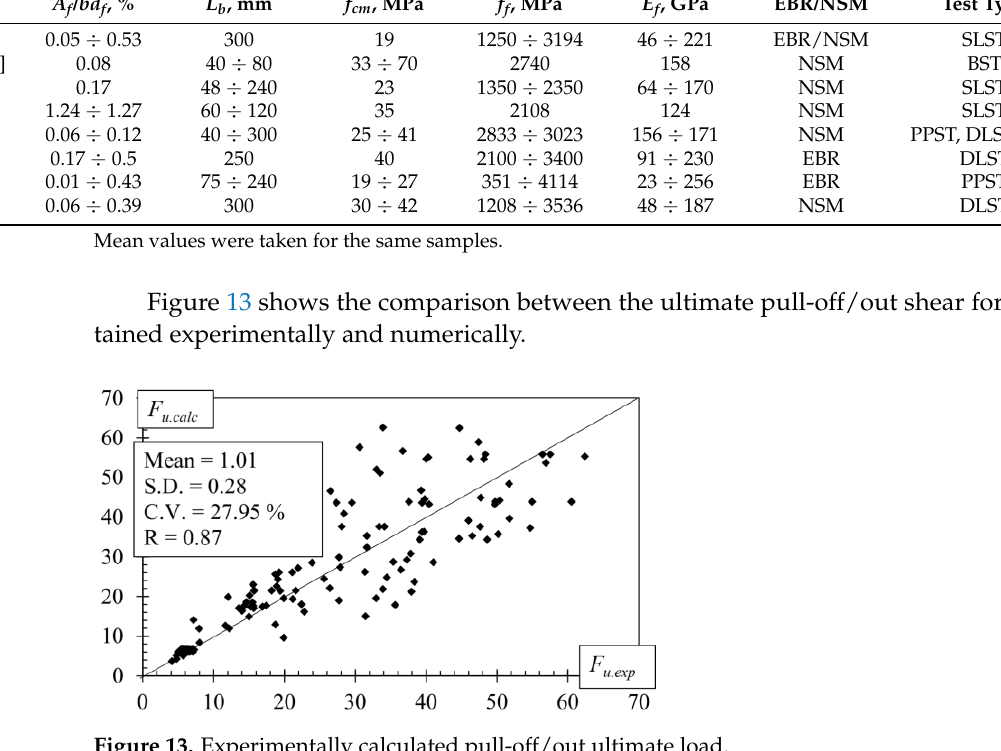
Table 2. Main parameters of pull-off/out shear tests.